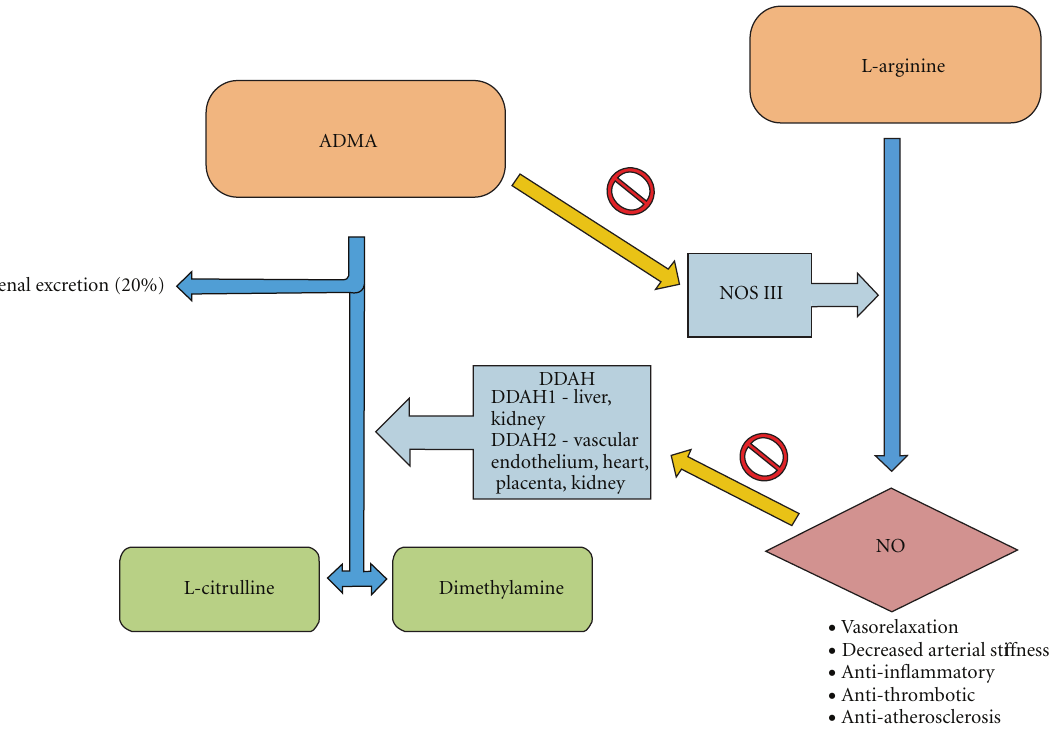
Figure 1: The nitric oxide